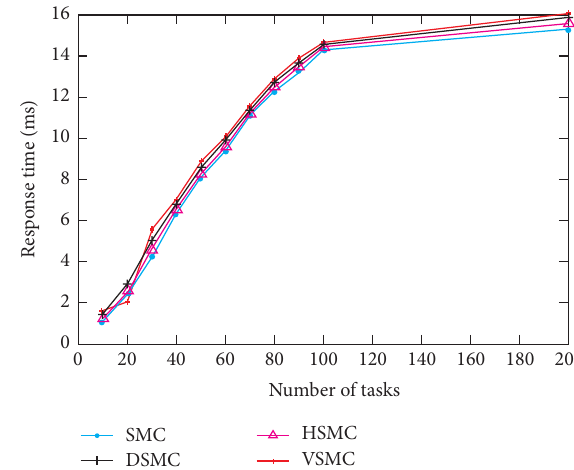
Figure 6: Comparison of load balancing in clusters.